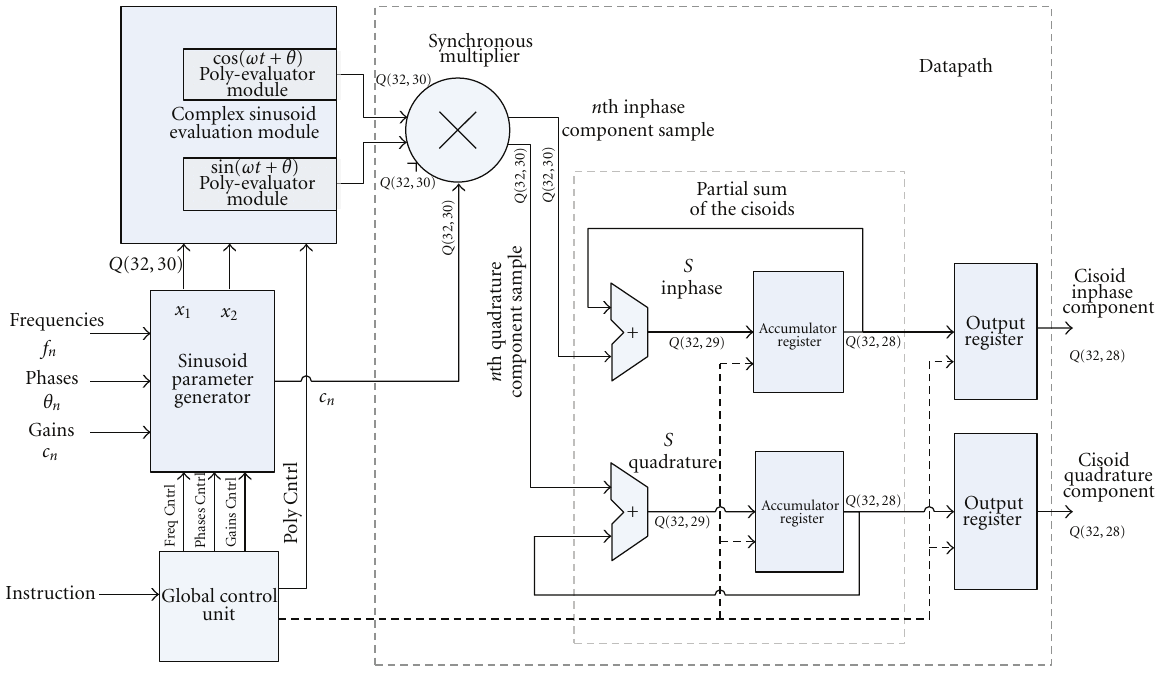
Figure 1: General architecture of the SOC fading channel